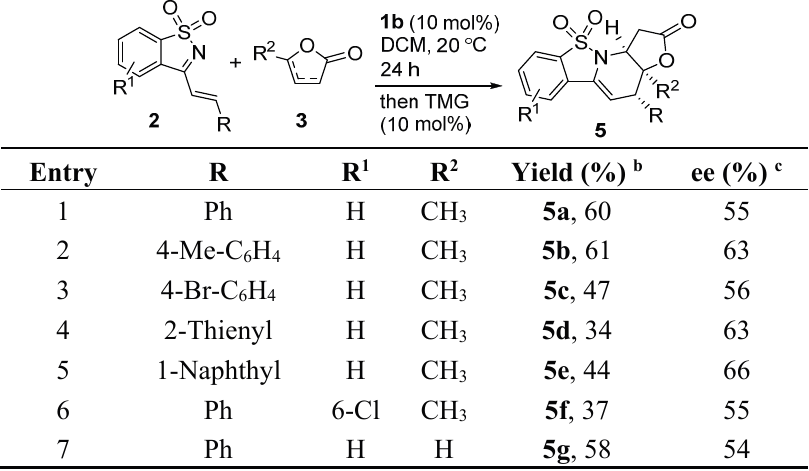
Table 5. Substrate scope of exo -type cycloadditions catalyzed by 1b a .